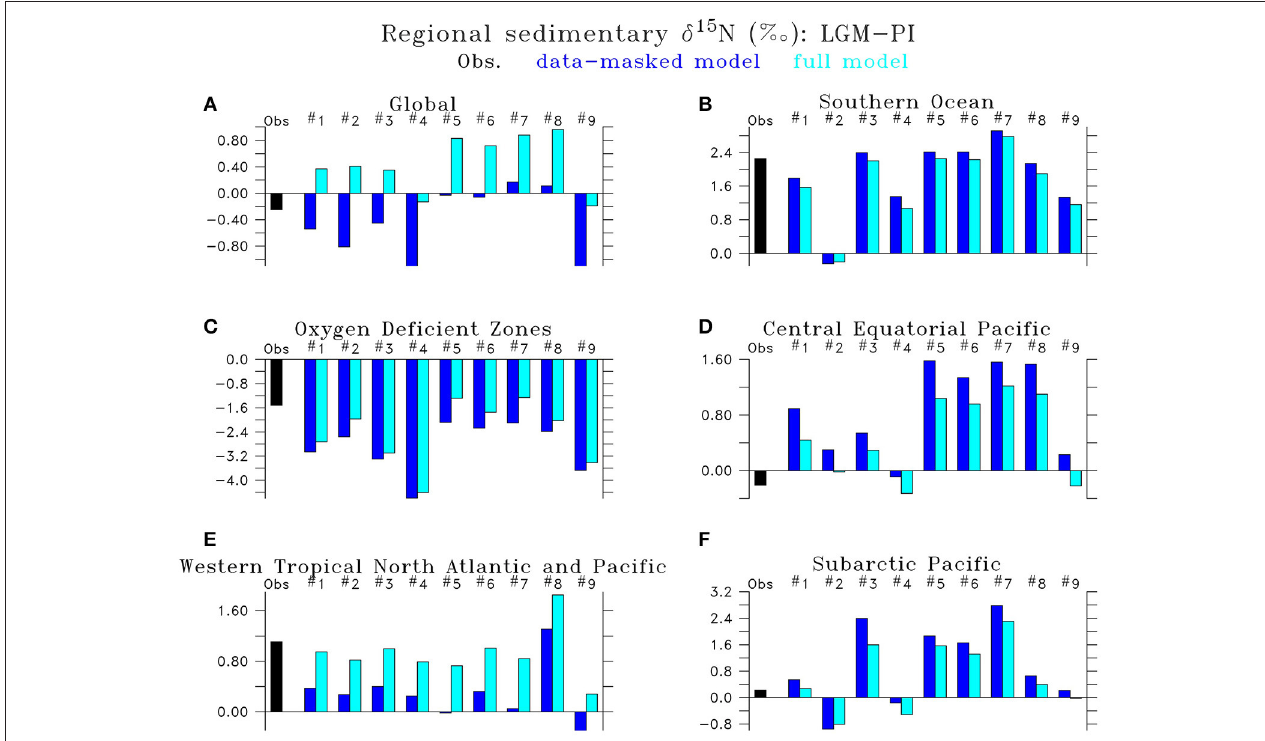
FIGURE 11 | Regional Last Glacial Maximum minus Preindustrial δ 15 N differences of LGM model simulations (#1) LGMctl, (#2) LGMloFe, (#3) LGMhiFe, (#4) LGMloPO 3 − 4 , (#5) LGMhiPO 3 − 4 , (#6) LGMmidWCNl, (#7) LGMhiWCNl, (#8) LGMloSedNl, (#9) LGMhiSedNl in the (A) global ocean, (B) Southern Ocean ( < 40 ◦ S), (C) oxygen deficient zones (minimum O 2 < 10 mmol m − 3 ), (D) Central Equatorial Pacific (170 ◦ W–130 ◦ W, 5 ◦ N–5 ◦ S), (E) Western Tropical North Atlantic and Pacific (0–25 ◦ N, western 50 ◦ of Atlantic and Pacific basins), and (F) Subarctic Pacific (40–65 ◦ N). “Data-masked” model (dark blue left bar) only includes locations where data exist, whereas the “full” model (light blue right bar) averages over the entire region.